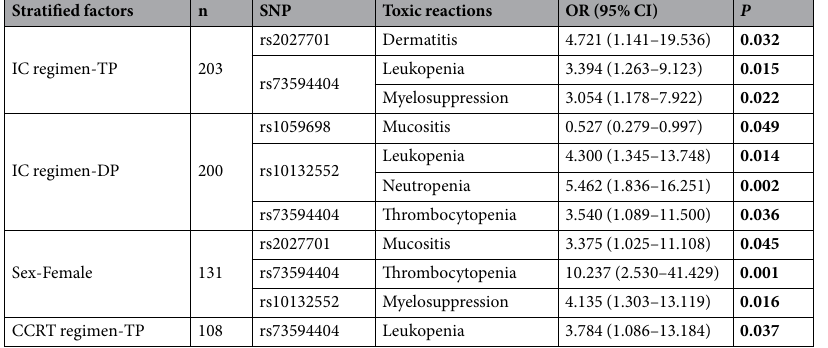
Table 4. Stratification analysis of association between SNPs in lncRNA-p53 regulatory network genes and the toxic reactions in NPC patients. Abbreviations: OR, odds ratio; CI, confidence interval; P value < 0.05 is shown in bold.